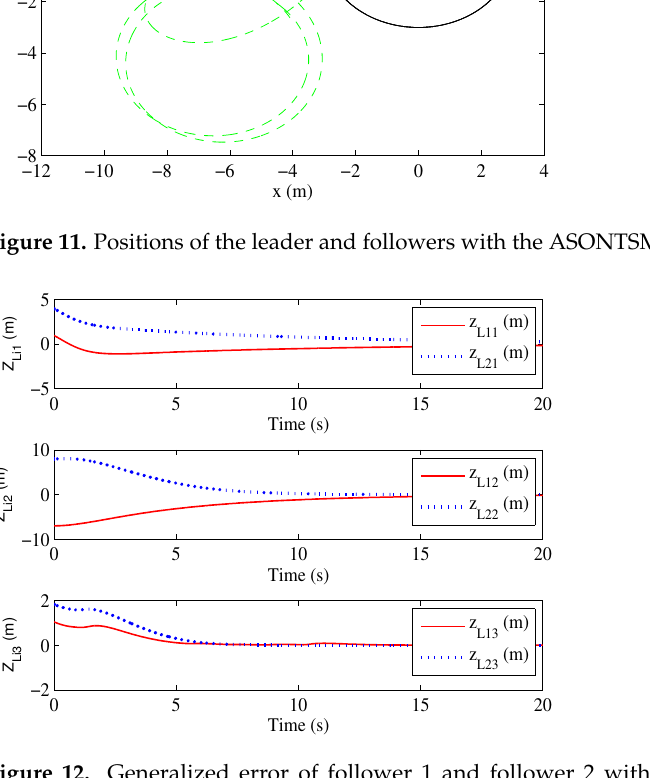
Figure 12. Generalized error of follower 1 and follower 2 with respect to the leader with the ASONTSMC method.